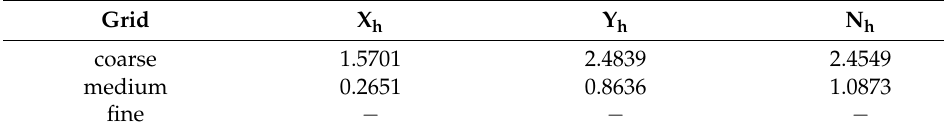
Figure 5. Grid dependency analysis. Table 4. RMSE of the grid dependency analysis, as shown in Figure 4.